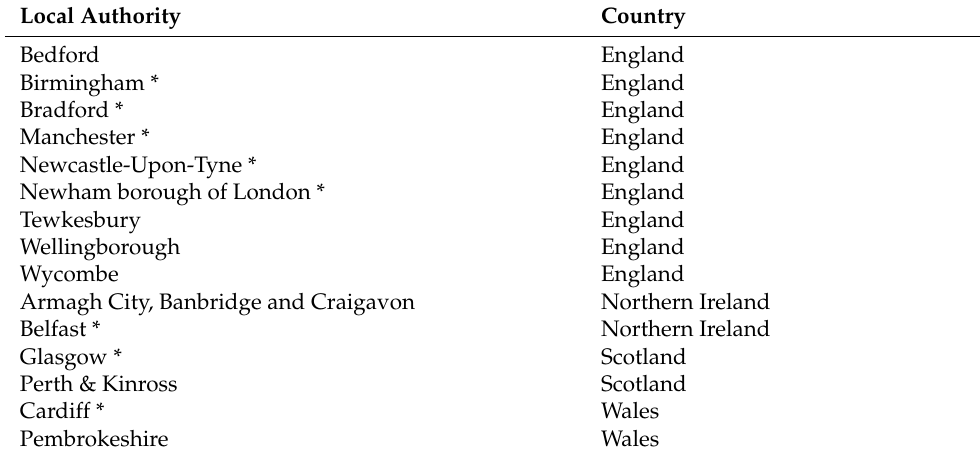
Table 1. List of research locations by country. Urban areas are marked with *. Local